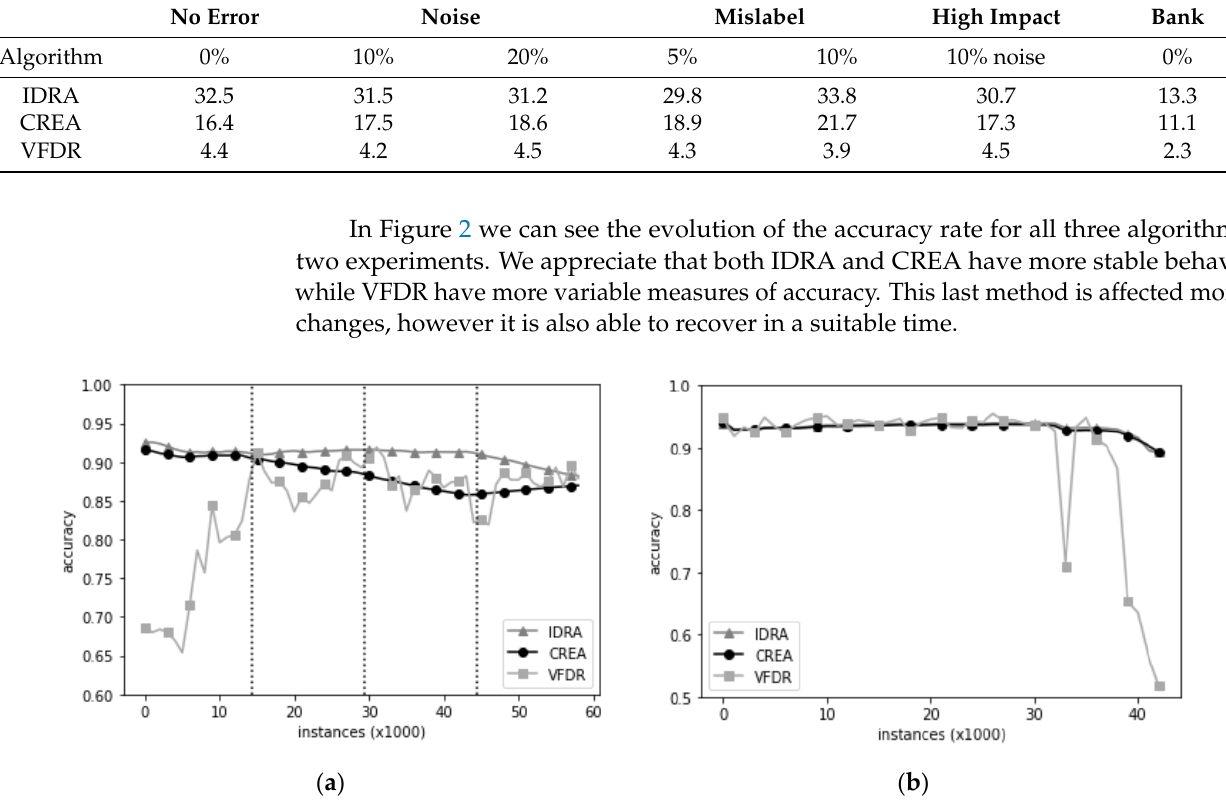
Figure 2. Accuracy evolution of IDRA, CREA and VFDR with two data streams. The concept drifts are represented with dashed lines. ( a ) Accuracy evolution of the three algorithms in the 10% noise simulated scenario. ( b ) Accuracy evolution of the three algorithms in one of the generated bank data streams.